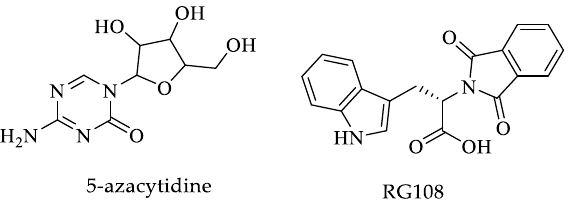
Figure 15. Structure of DNA methyltransferase inhibitors of E. histolytica.